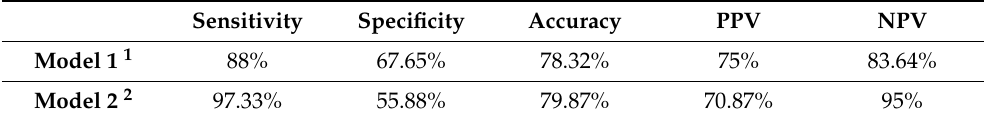
Table 7. Diagnostic performance of magnetic resonance imaging in differentiation of idiopathic granulomatious mastitis and breast